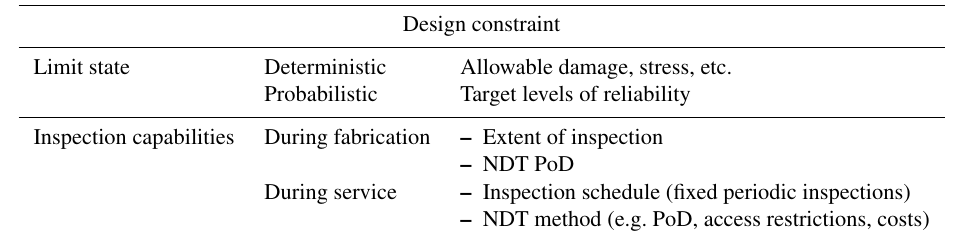
Table 2. Design constraints for damage-tolerant fracture mechanics